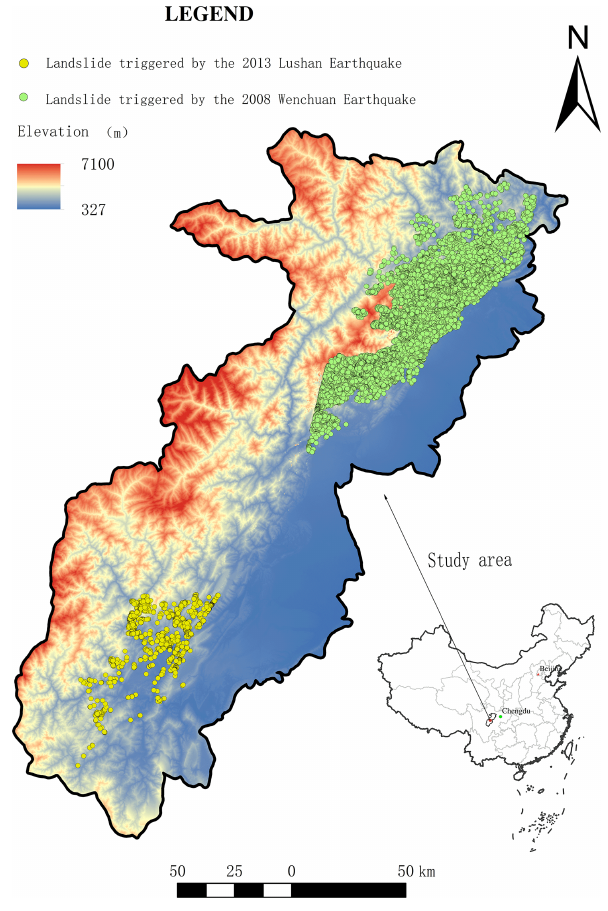
Figure 1. Landslides triggered by the 2008 Wenchuan and 2013 Lushan